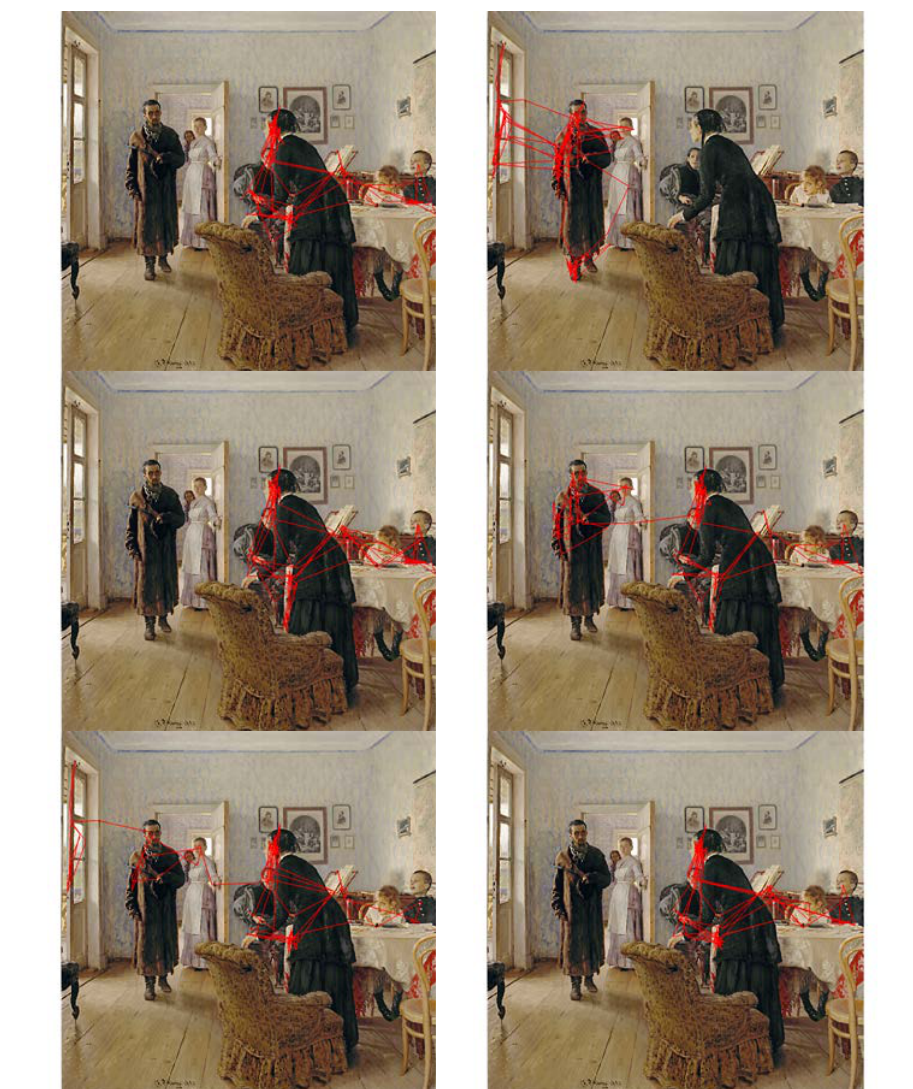
Figure 17. Sub-sequences of the full 720 fixations that STAR executes on the paint- ing. 103 fixations each, the top left being the first, followed by the second and third on the left, and the 4th, 5th and 6th on the right, from top to